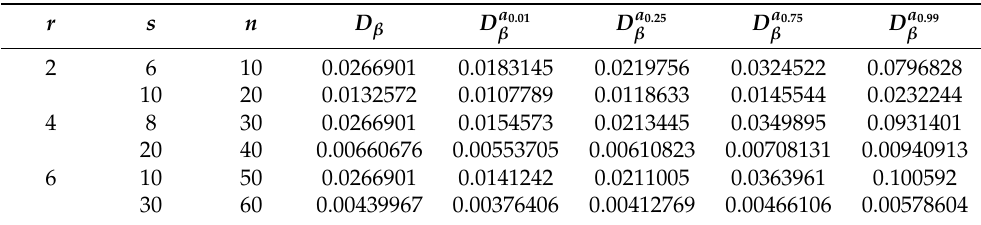
Table 3. Unconditional and conditional lower β -expectation tolerance factors, D β and D a ε W ( α , θ ) model based on X = ( X r : n ,..., X s : n ) when α = 1 and β =